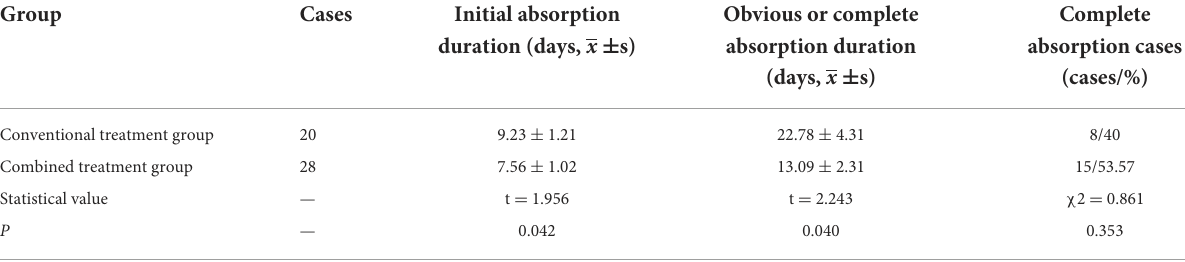
TABLE 3 Comparison of the initial and complete absorption duration of lung infection lesions between the groups.